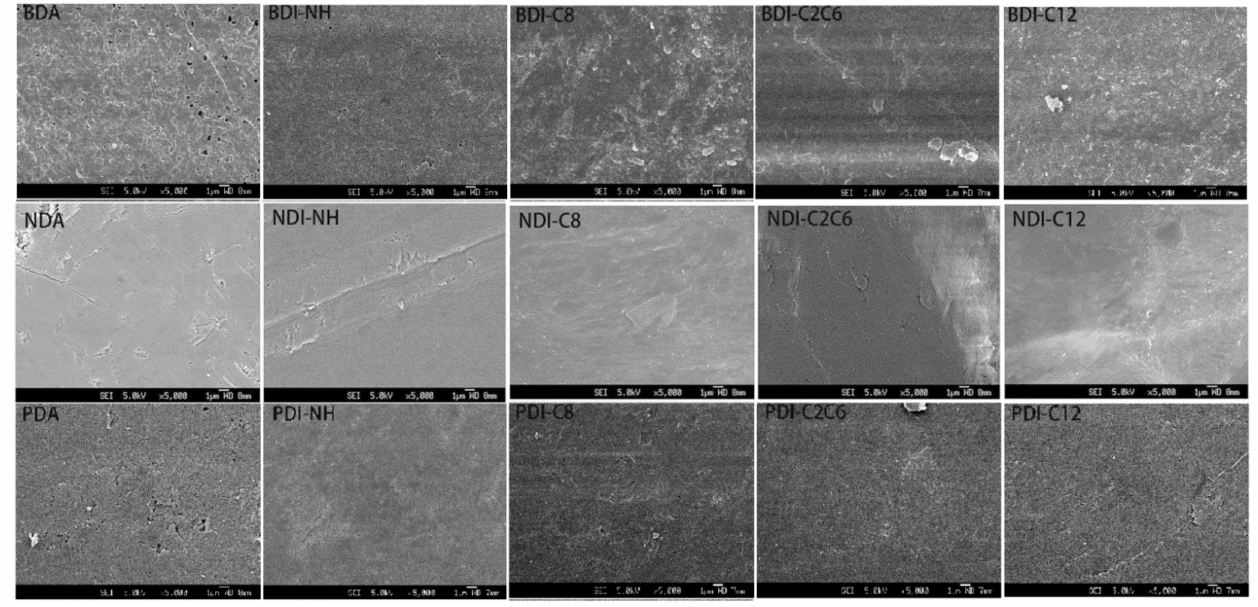
Figure 5. SEM pictures of the surfaces of as-prepared BDI, NDI, and PDI sheets.